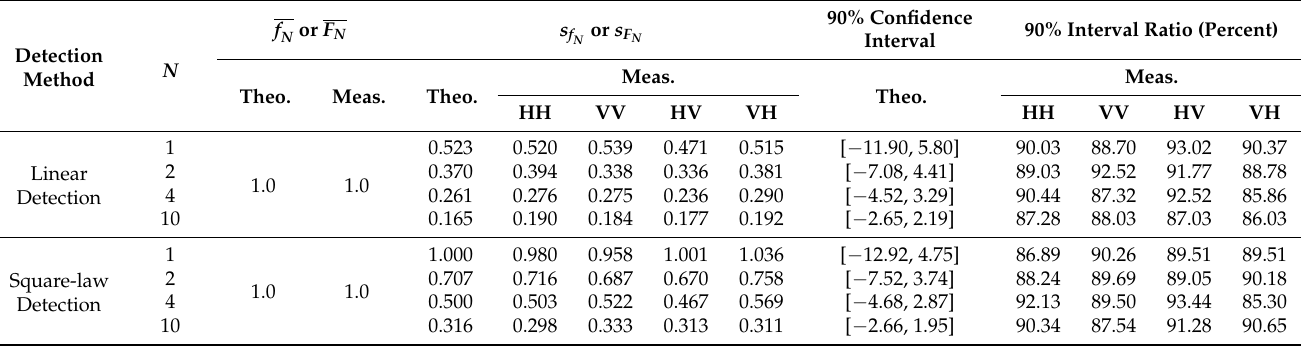
Table 3. Statistical results of the backscatter from rice field scene 2 when N = 1, 2, 4, and 10, for linear and square-law detection.